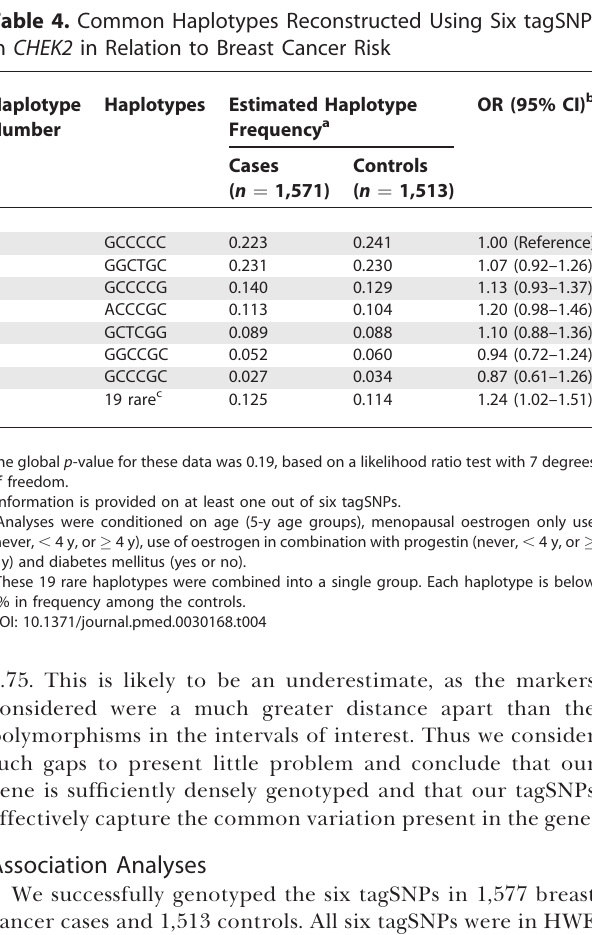
Table 5. Overall Association of the CHEK2 * 1100delC